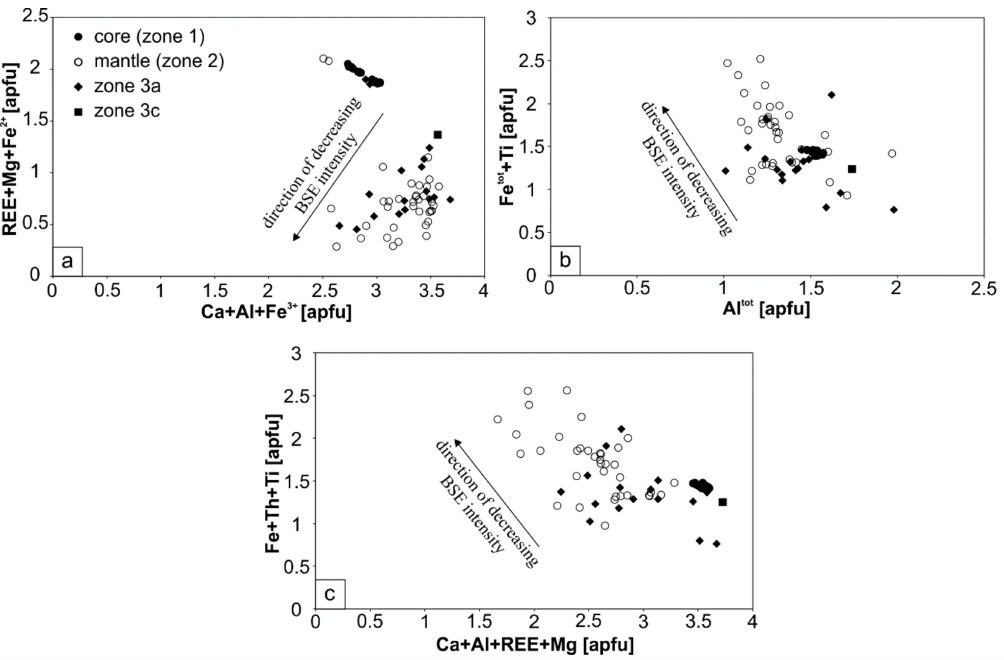
Figure 6. Cationic plots showing possible substitutions in allanite structure: ( a ) Ca + Al + Fe 3 + vs. REE + Mg + Fe 2 + , ( b ) Al tot vs. Fe tot + Ti, (Fe tot —total Fe), and ( c ) Ca + Al + REE + Mg vs. Fe + Th +